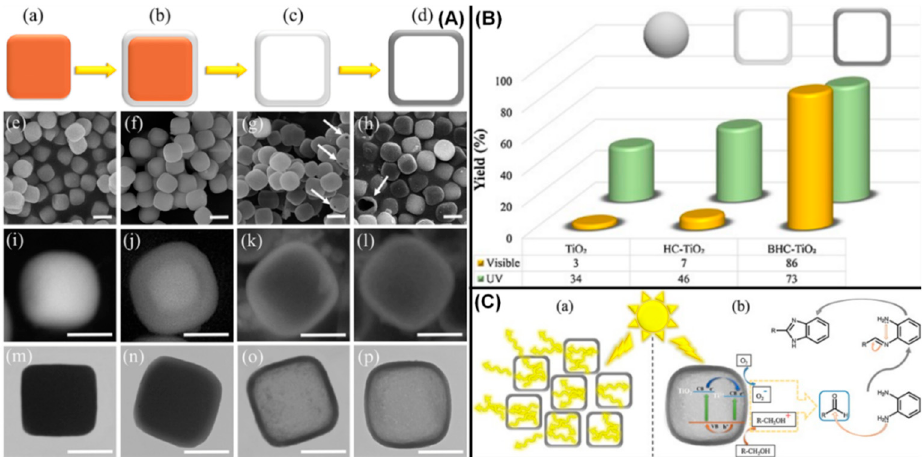
Figure 2. ( A ) Overall flowchart for fabrication of black hollow nanocubic (BHC)-TiO 2 ( a – p ), ( B ) Comparison photocatalytic activity of different TiO 2 nanostructures in the synthesis of benzimidazole under UV and visible conditions; ( C ) Schematic diagram of the light scattering effect caused by BHC-TiO 2 nanocubes ( a ) and schematic of the proposed mechanism for benzimidazole preparation by BHC-TiO 2 architecture ( b ) (reproduced with permission from ref. [46]).